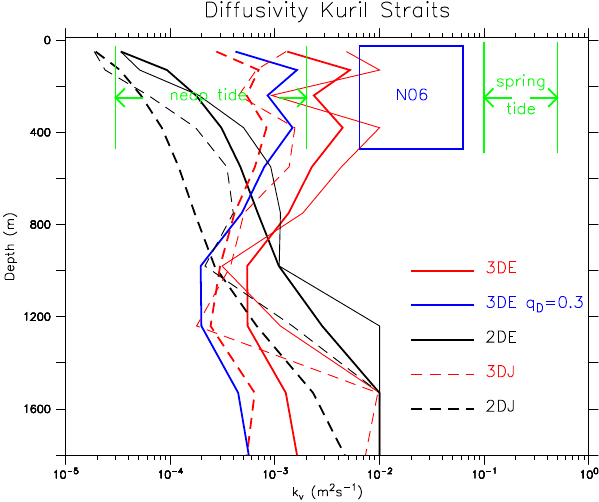
Fig. 11. Comparison of simulated (lines) k v with observations for the Kuril Straits (151 ◦ E, 46.5 ◦ N). Green arrows denote the range of diffusivity estimates from microstructure measurements during spring and neap tides (Itoh et al., 2010, 2011) and the blue square shows an estimate of the time mean (Nakamura et al., 2006). The observational estimates represent the upper 500m of the water col- umn. The blue line is experiment 3DE with reduced local dissi- pation of diurnal tide energy ( q D = q K1 = q O1 = 0 . 33). Both 10d (thick) and equilibrium (model year 4000, thin) solutions are shown.